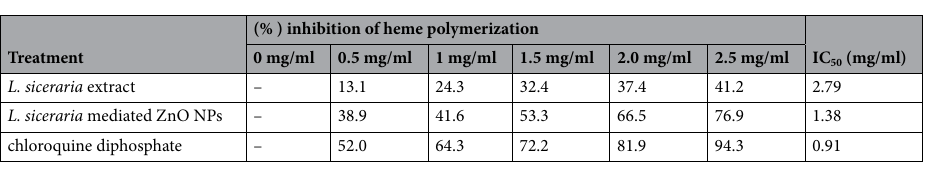
Table 4. Inhibition of